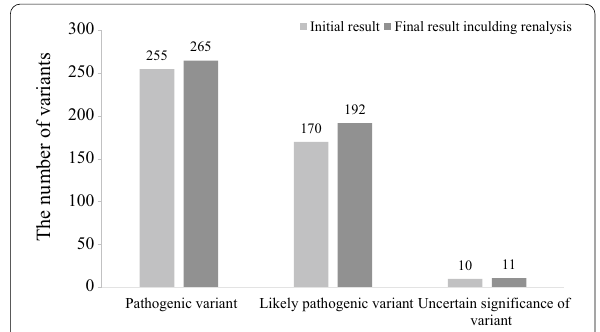
Fig. 1 Comparison of the number of pathogenicityof identified variants between the initial and final results, including the reanalysis